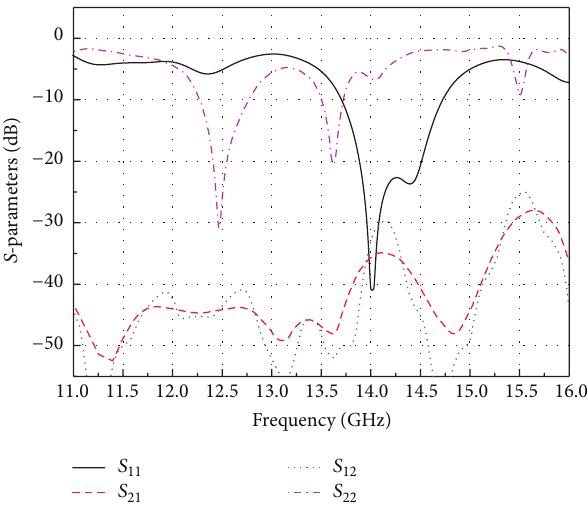
Figure 4: Simulated 𝑆 -parameters for the 1 × 8 linear array.